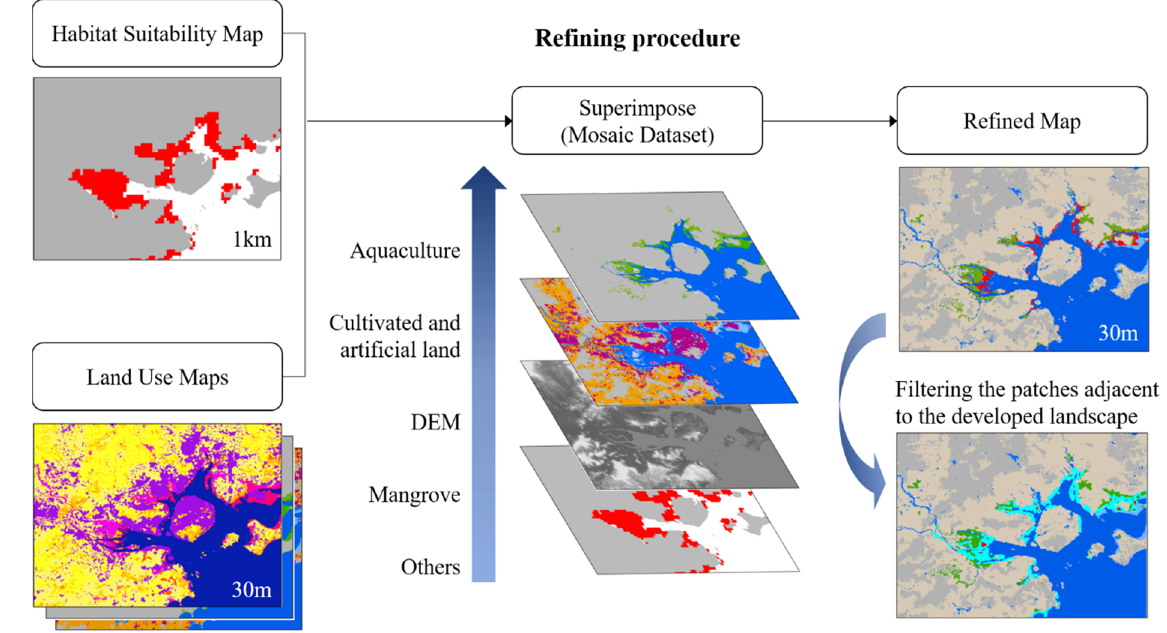
Figure 2. Refining procedure to obtain high-resolution mangrove habitat maps.